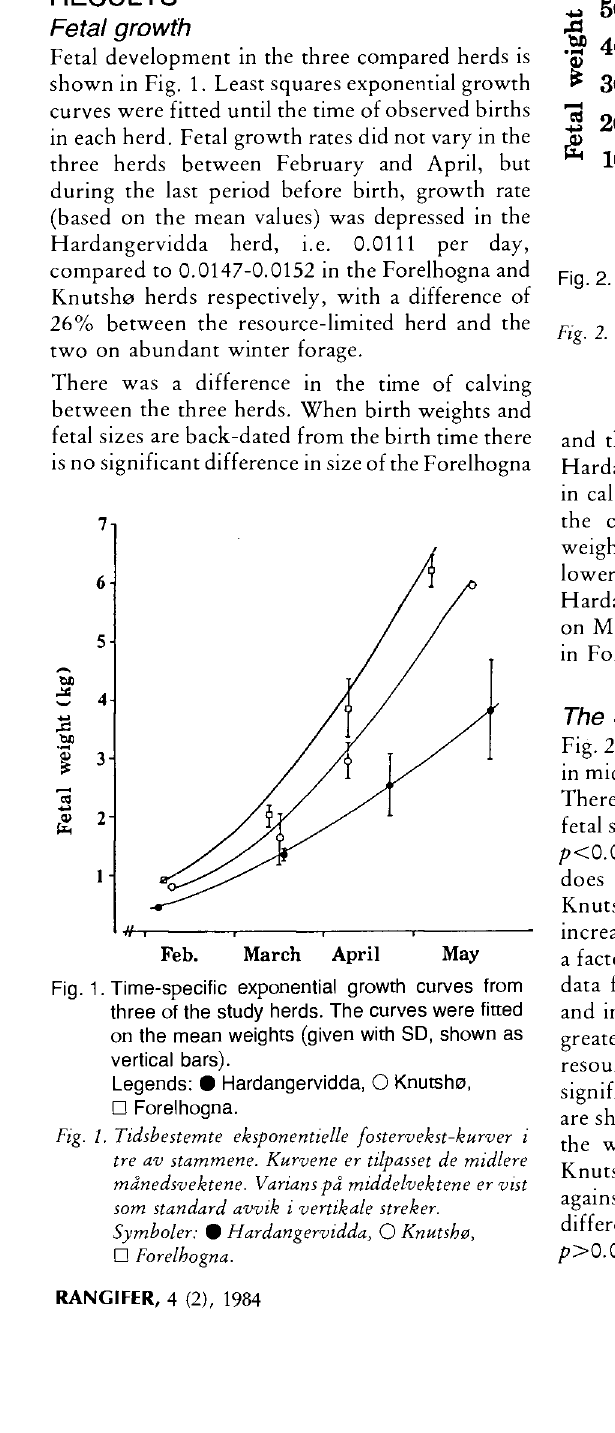
Fig. 1. Tidsbestemte eksponentielle fostervekst-kurver i tre av stammene. Kurvene er tilpasset de midlere månedsvektene.